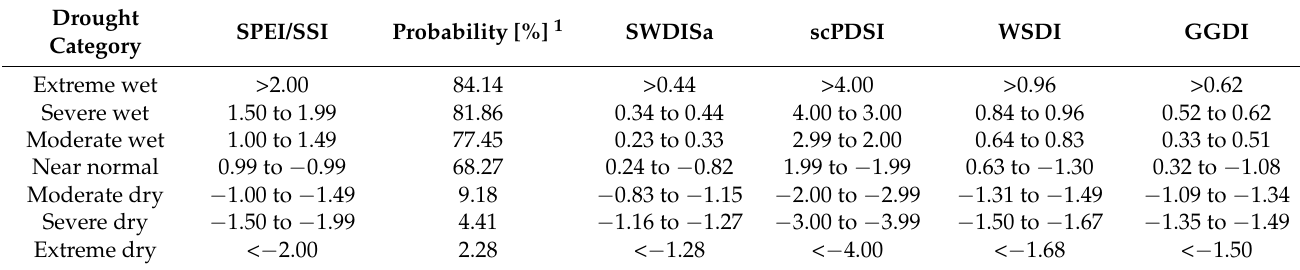
Table 2. Drought categories for the values of SPEI, SSI, SWDISa, scPDSI, WSDI, and